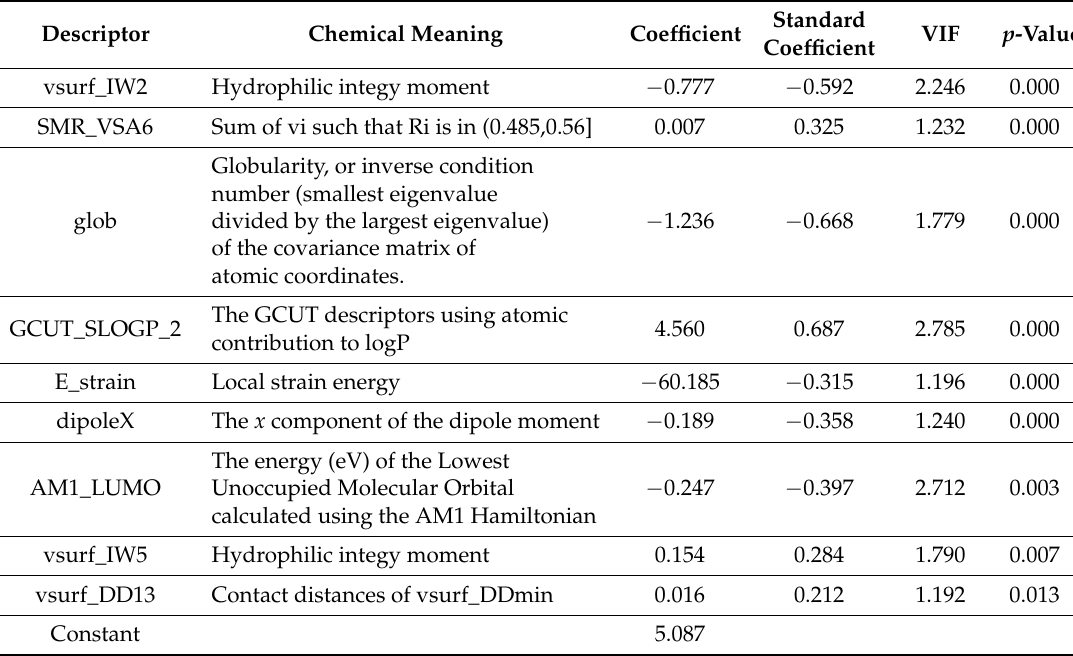
Table 2. Statistical parameters of two QSAR models for LXR β and LXR α agonists.